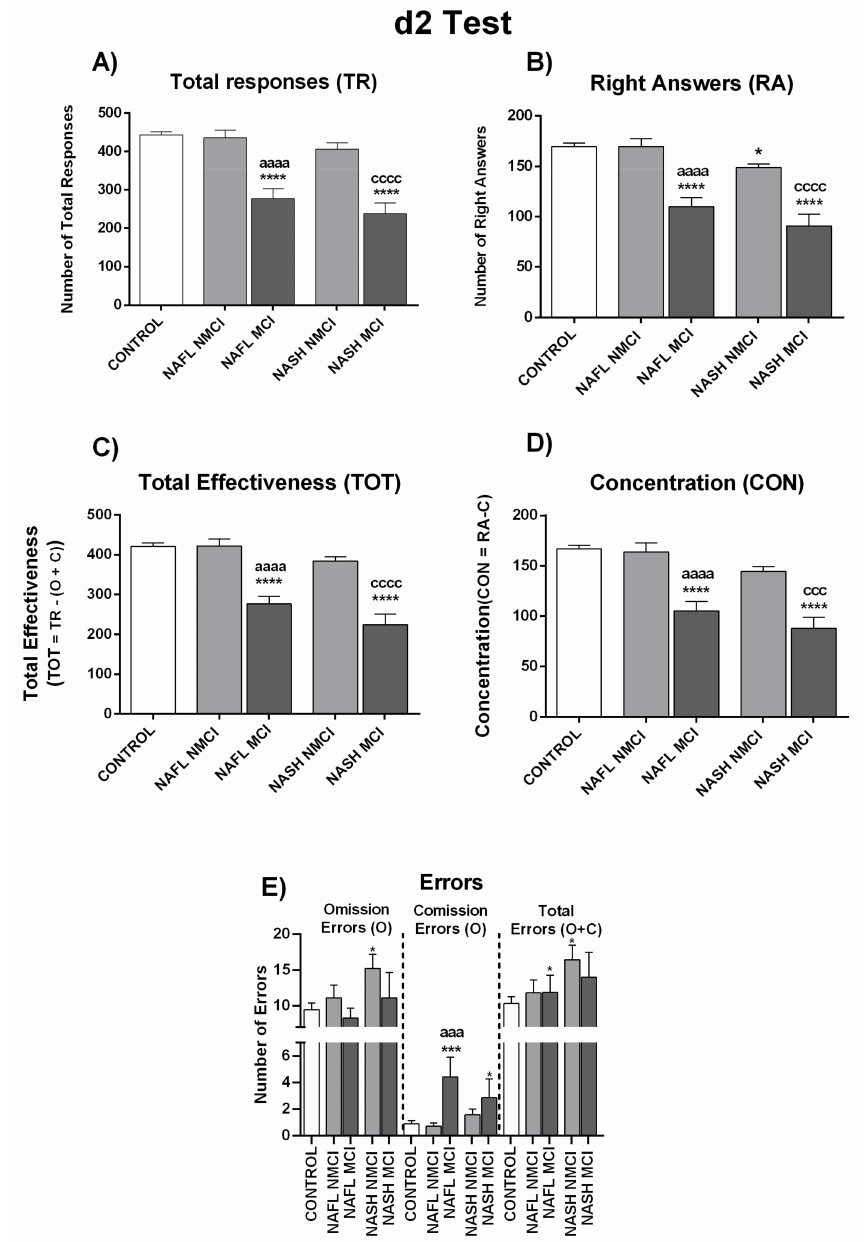
Figure 6. Performance of NAFL and NASH patients classified by the new score as with (MCI) or without (NMCI) mild cognitive impairment in d2 test. ( A ) Number of total responses (TR), ( B ) right answers (RA), and ( C ) total effectiveness (TOT), which was calculated by: TOT= TR − (O + C) ( D ) Concentration index (CON), which was calculated by: CON = RA − C. ( E ) Number of errors by Omission (O), Comission (C), and total errors (O + C). Results are the mean ± SEM. * p < 0.05; *** p < 0.001; **** p < 0.0001 vs. control group (CNT), aaa p < 0.001; aaaa p < 0.0001, NAFL MCI vs. NAFL NMCI; ccc p < 0.001; cccc p < 0.0001, NASH MCI vs. NASH